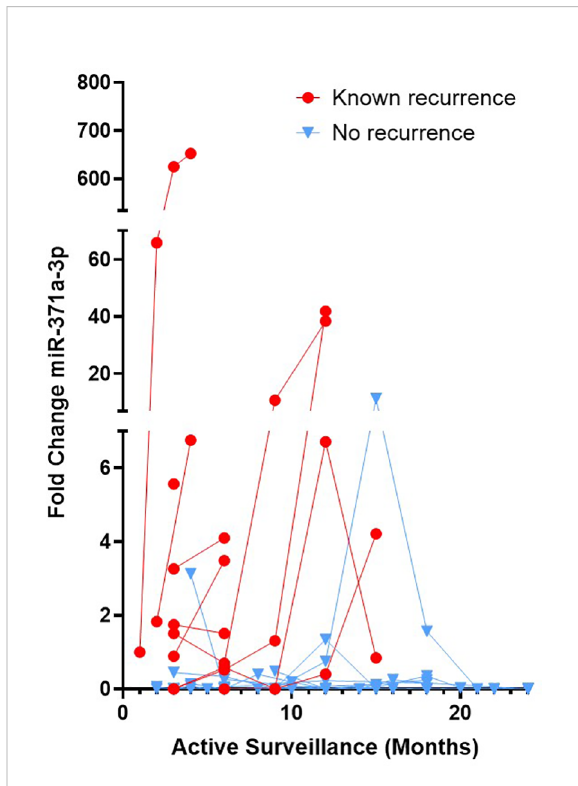
3p when adopting a protocol with pre-ampli fi cation. Sequential serum samples from Stage 1 TGCT patients undergoing active surveillance were analysed for serum miR-371a-3p via RT-PCR including a cDNA pre-ampli fi cation step. Patients with known recurrence (red dots) and known non-recurrence (blue triangles) are shown. FC calculated via relative expression to the